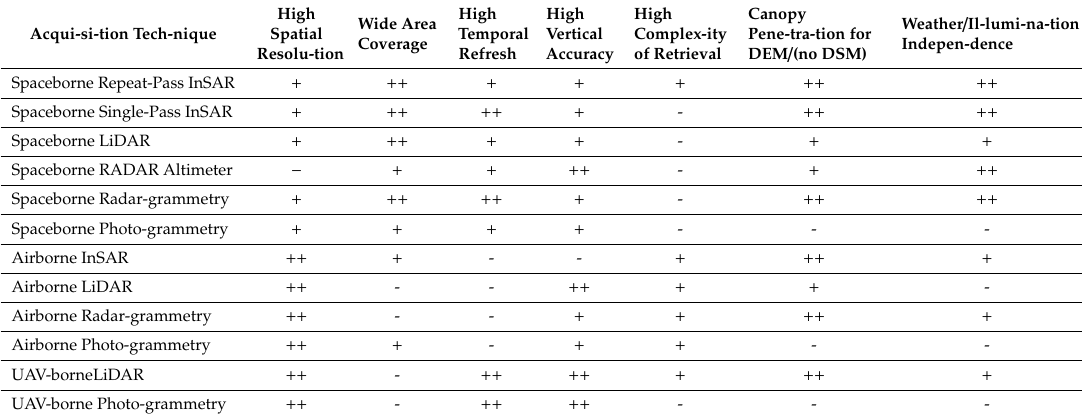
Table 1. Semantic categorization of potentials and practicality of RS platforms and RS techniques for elevation data acquisition; inspired by Mulder et al., [136]: −− = no, − = low, + = medium and ++ = high